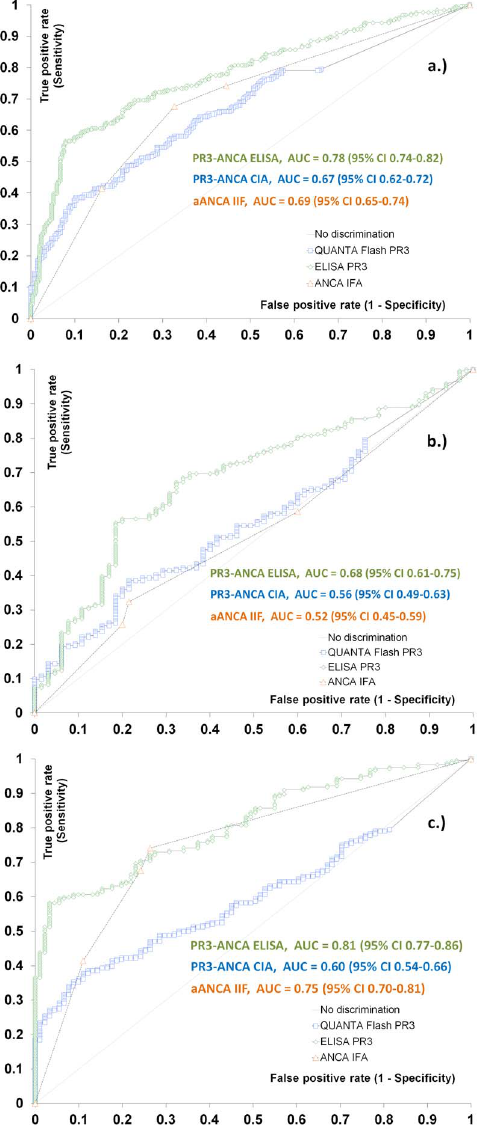
Figure 1. Comparative receiver operating characteristic (ROC) curves analysis. Comparative ROC analysis is shown for PR3-ANCA by ELISA, chemiluminescence immunoassay (CIA) and ANCA by indirect immunofluorescence (pANCA). Primary sclerosing cholangitis (PSC) vs. all liver controls (a) and vs. autoimmune hepatitis (AIH) (b), and vs. primary biliary cirrhosis (PBC) (c). Area under the curve (AUC) and 95% Confidence Intervals (CI) values for the individual assays are presented in the